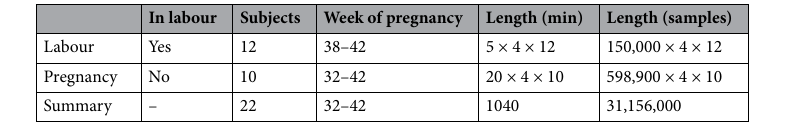
Table 1. Summary of the datasets used for the